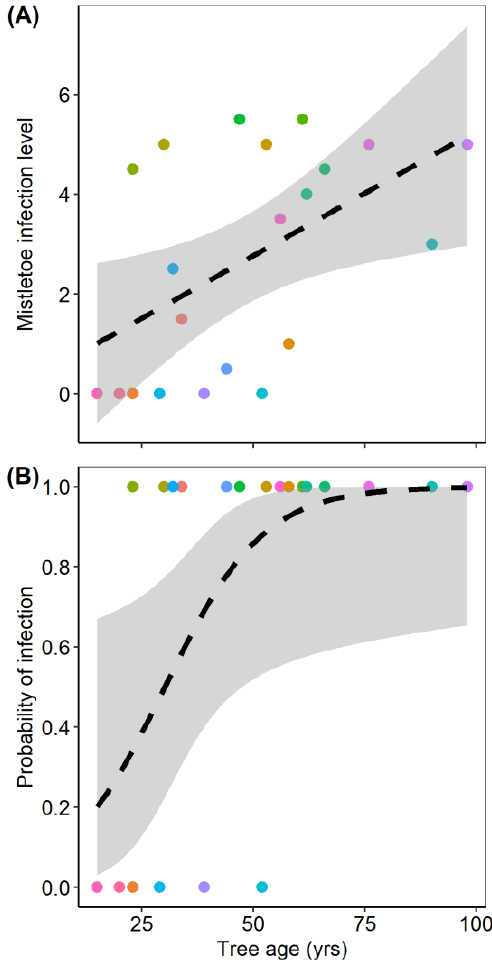
Figure 4. Relationship between tree age (total annual xylem rings) and mistletoe infection level ( A ) and the probability of mistletoe infection ( B ). The different colored symbols correspond to individual trees; the dashed-line shows the population line of fit, with shading indicating the 95% confidence interval. The panels show untransformed data.